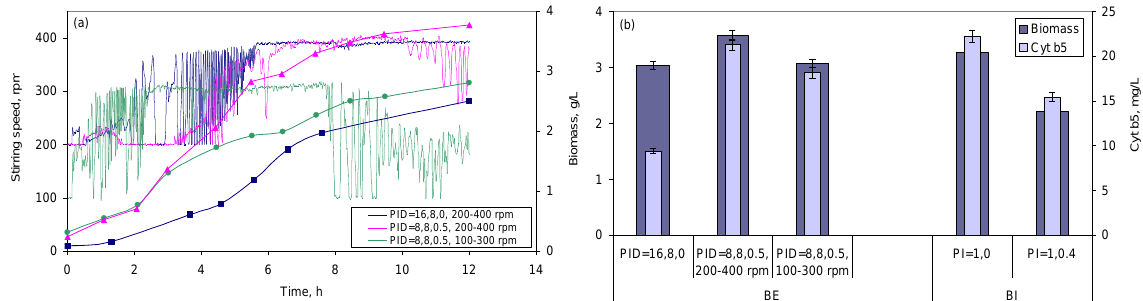
Figure 4. Effect of PID controller parameters on biomass and cyt b5 production. Initial glucose concentration 10 g/L, aeration set at 0.5 vvm, and dissolved oxygen at 2%. ( a ) Variation of stirring speed with PID parameters in the BE and corresponding biomass profile observed along with the fermentation. In blue: PID set at 16, 8, 0; cascade mode with stirring speed set between 200 and 400 rpm; biomass data in squares. In pink: PID set at 8, 8, 0.5; cascade mode with stirring speed set between 200 and 400 rpm; biomass data in triangles. In green: PID set at 8, 8, 0.5; cascade mode with stirring speed set between 100 and 300 rpm; biomass data in circles. ( b ) Influence of PID parameters and stirring speed on biomass and cyt b5 concentrations attained in the BE and BI. In the BI, the cascade mode was set with stirring speed that varied between 200 and 400 rpm.